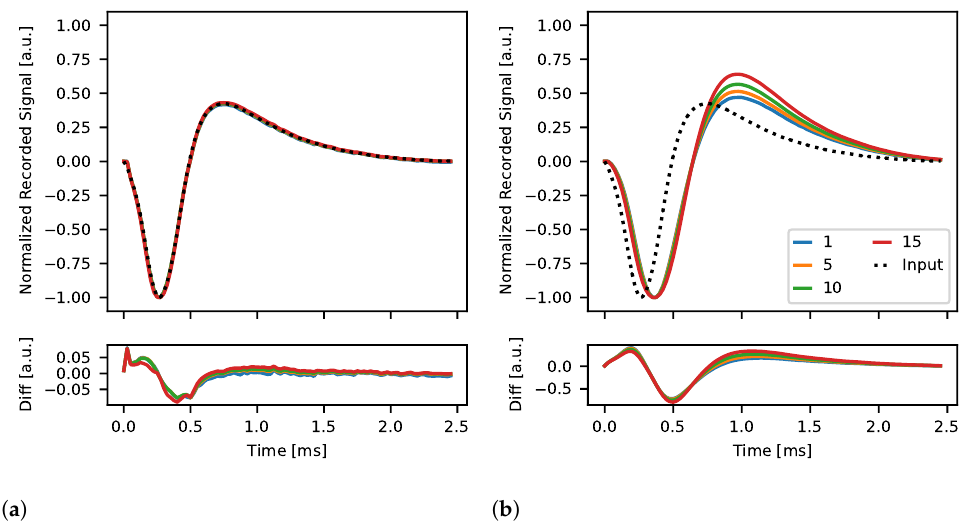
Figure 24. Normalized readout response of the test channel for artificial spike pattern stimulation at gain = 250 and different amplitudes controlled by DAC 4bit value with ( a ) maximum ( b ) minimum setting of cut-off frequency of the low-pass filter. Bottom plots show differences between obtained normalized signals and reference